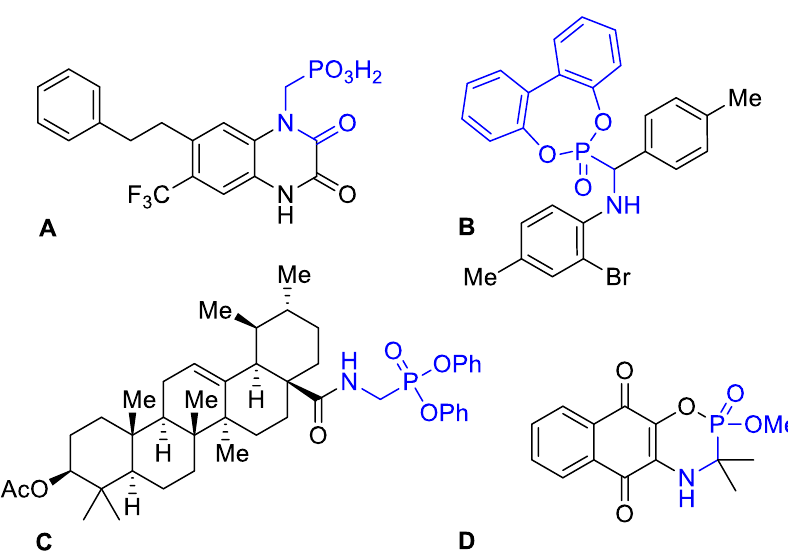
Figure 1. Aminophosphonic acid and aminophosphonates of potential medical importance. ( A ) AMPA (α-amino-3-hydroxy-5-methyl-4-isoxazolepropionic acid) receptor antagonist [15]; ( B ) antimicrobial aminophosphonate [16]; ( C ) anti-HIV agent [17]; ( D ) cytotoxic agent against human cervical carcinoma [18].